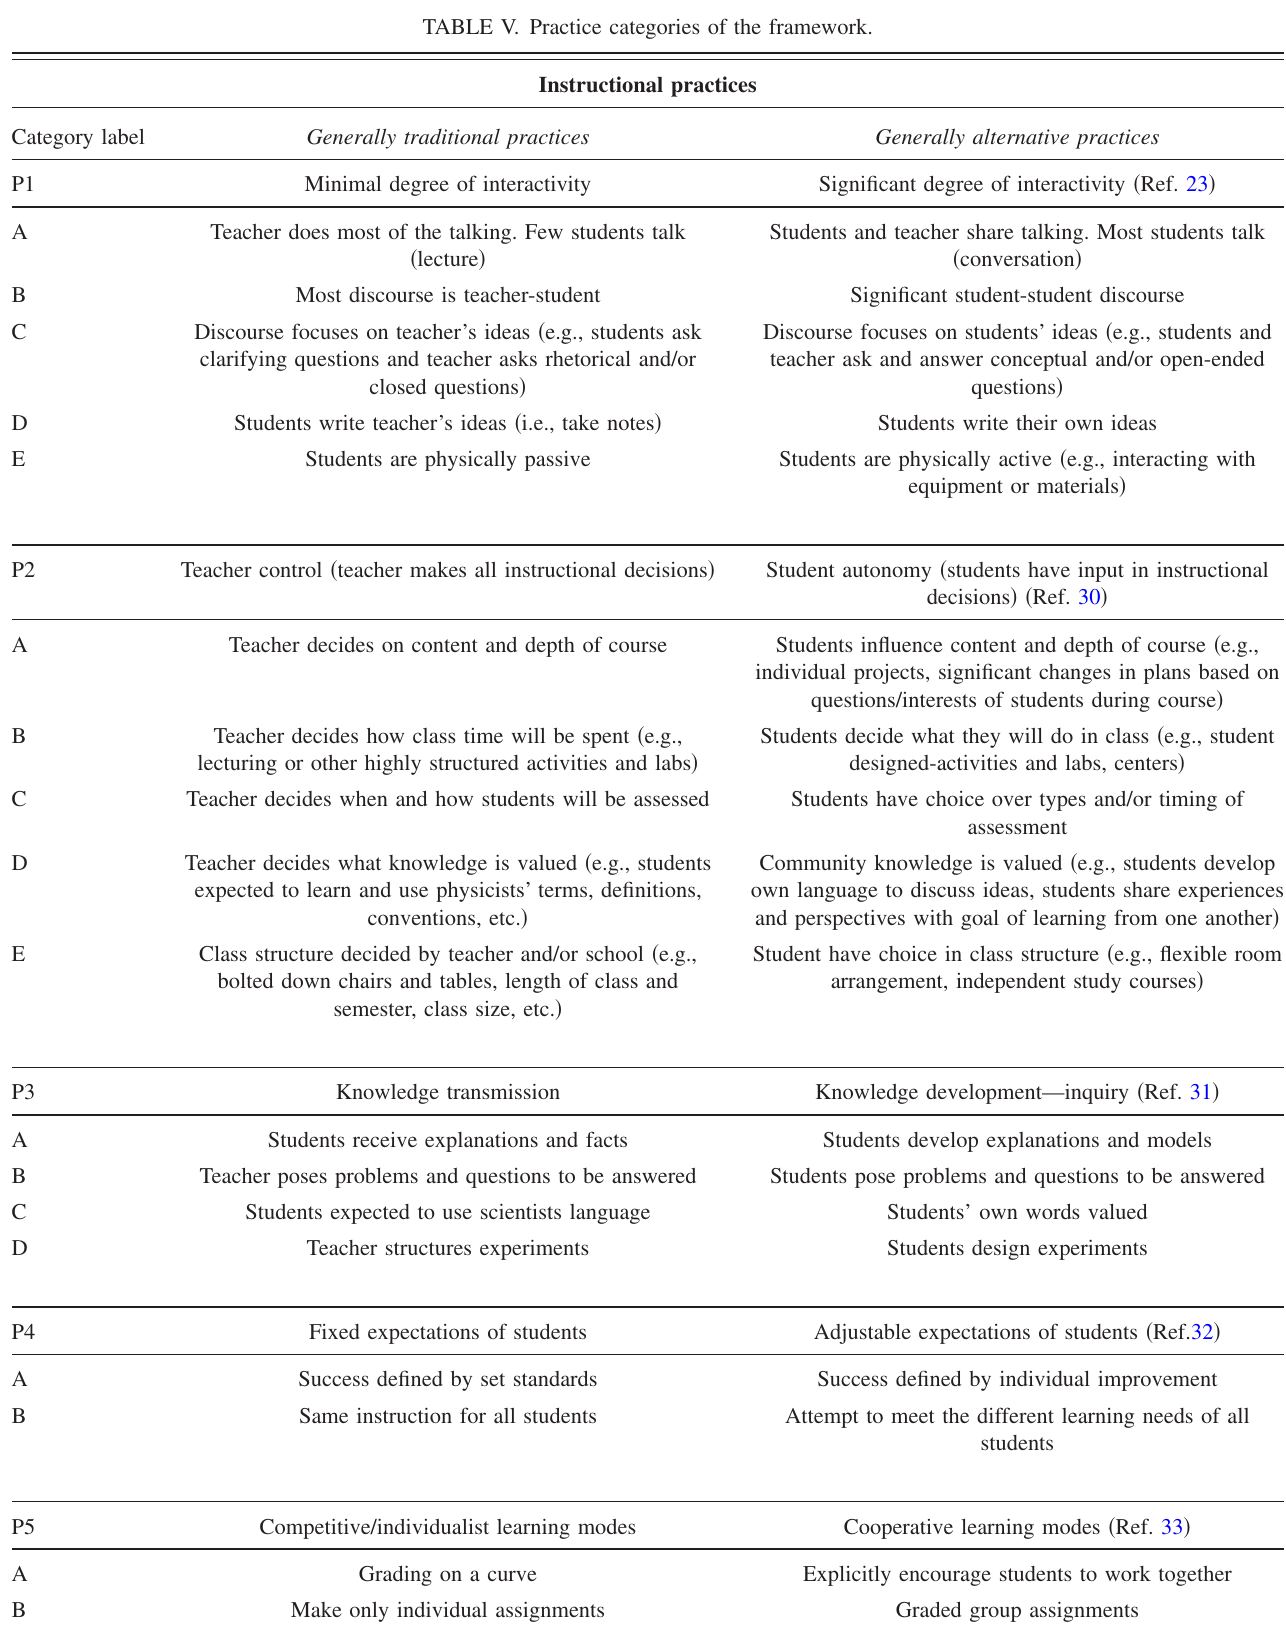
TABLE V. Practice categories of the framework. Instructional